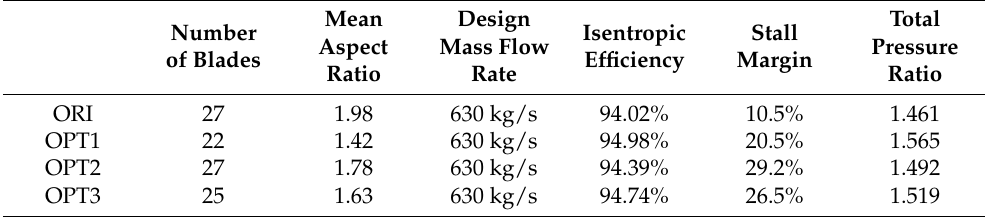
Table 3. Performance comparison of optimized samples at design